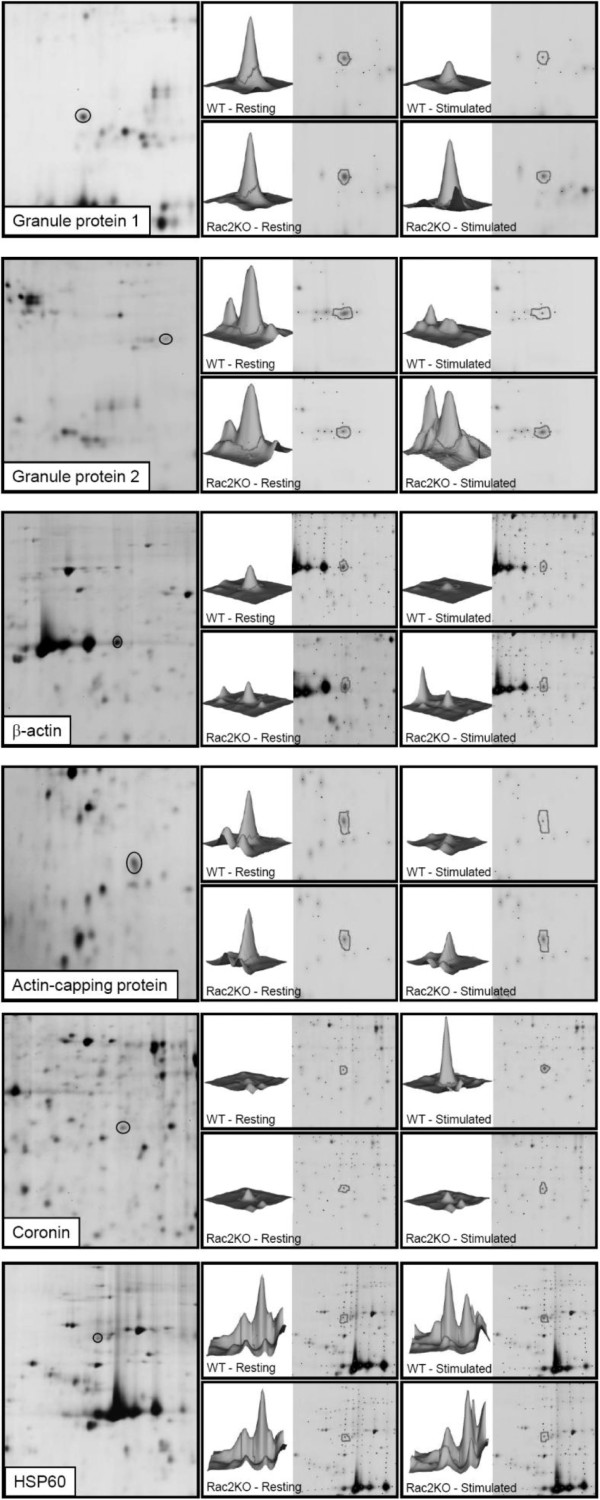
Magnified regions of 2D gels corresponding to identified proteins. Spots of interest from 2D gels (left panel) were quantified in four different samples corresponding to unstimulated and stimulated wild-type and Rac2-/- BMN (right four panels). The intensity of spots is also shown as 3D histograms.